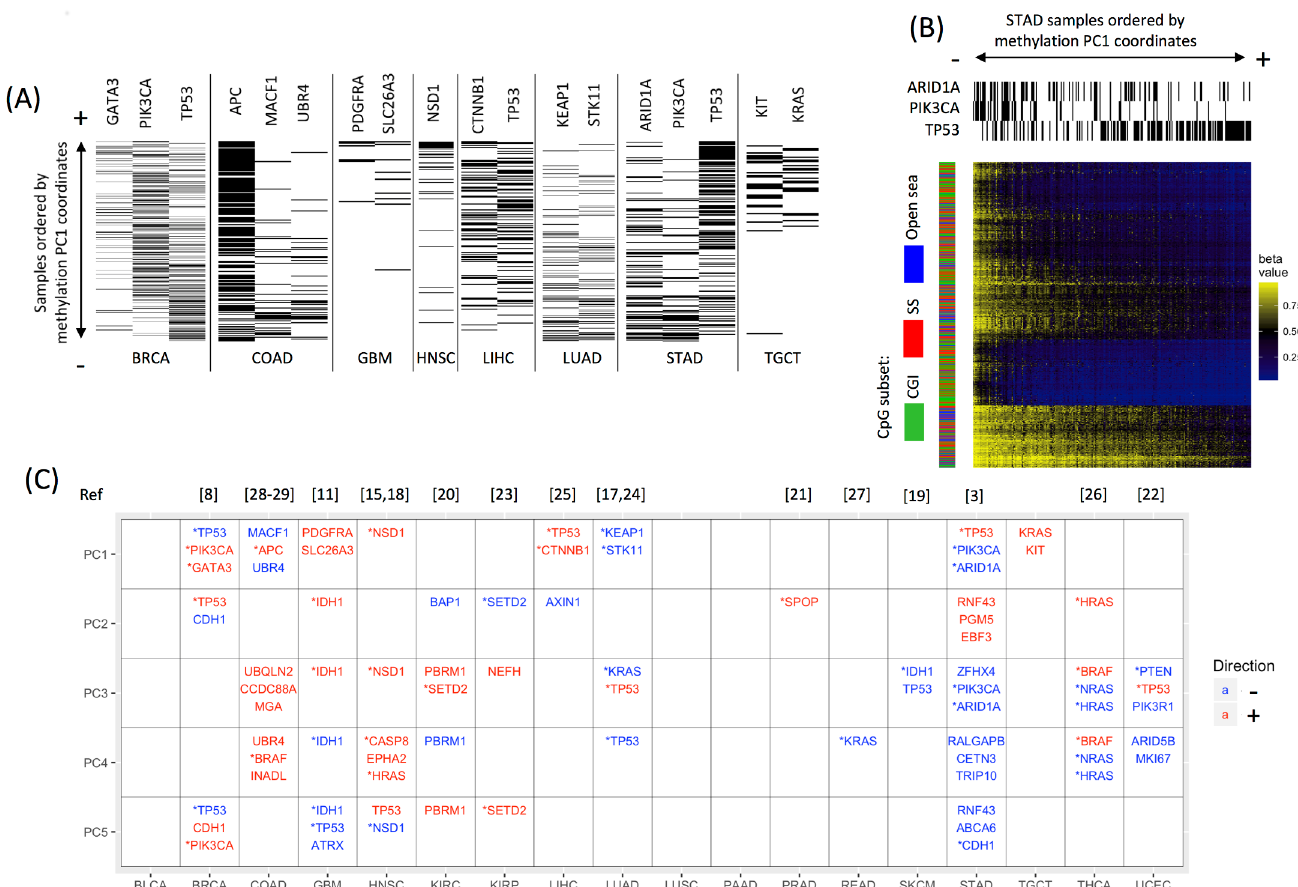
Fig 1. Driver gene mutations are significantly associated with DNA methylation in various cancers. (A) Examplesof mutations in 15 driver genesthat displayan uneven distribution along the first principalcomponent (PC1) of DNAm, biased toward either the positive extreme (+) or the negativeextreme (-). Tumor samples are orderedvertically by their coordinateson PC1, from small (-, bottom ) to large (+, top ). A black line indicates the presenceof the mutated driver gene in a sample, whereasa white line indicatesits absence.Note that a sample’spresence at an extreme (+/-) of a PC does not necessarily correspond to high or low methylation. See Table 1 for cancer type abbreviations. (B) Exampleof a cancer with driver gene mutations unevenly distributed on PC1, resulting in distinct methylationpatterns: ARID1A/PIK3CA -mutated stomach adenocarcinomas (STADs) displaya methylationpattern distinct from TP53 -mutated STADs. Shown is a heat map of methylationlevels for the top 1,000 most heavilyweighted probes in PC1. Each column represents a sample orderedby its PC1 coordinate,from small (-, left ) to large (+, right ). Each row represents a probe site. The three column sidebars on the top indicatemutation status for TP53 , PIK3CA , and ARID1A . The row sidebar indicatesthe CpG subsets: CpG island (CGI), shores and shelves (SS; the 4-kb regionsflanking the CGIs), or open sea (i.e., probes outsideof CGIs and SSs). TP53 -mutated STADs display lower methylation levels at the selectedCpG sites than the majority of ARID1A / PIK3CA -mutated STADs. (C) In 15 of 18 cancer types examined, mutated driver genes were associatedwith one or more of the top five methylationPCs, shown as rows. The three driver genesmost significantly associatedwith each PC are reported. Driver genes associatedwith the negativeextreme of a PC are in blue, whereasassociations with the positive extreme are in red. * Some of these mutated driver genes were previouslyreportedin associationwith DNAm subtypes(corresponding referenceslisted at the